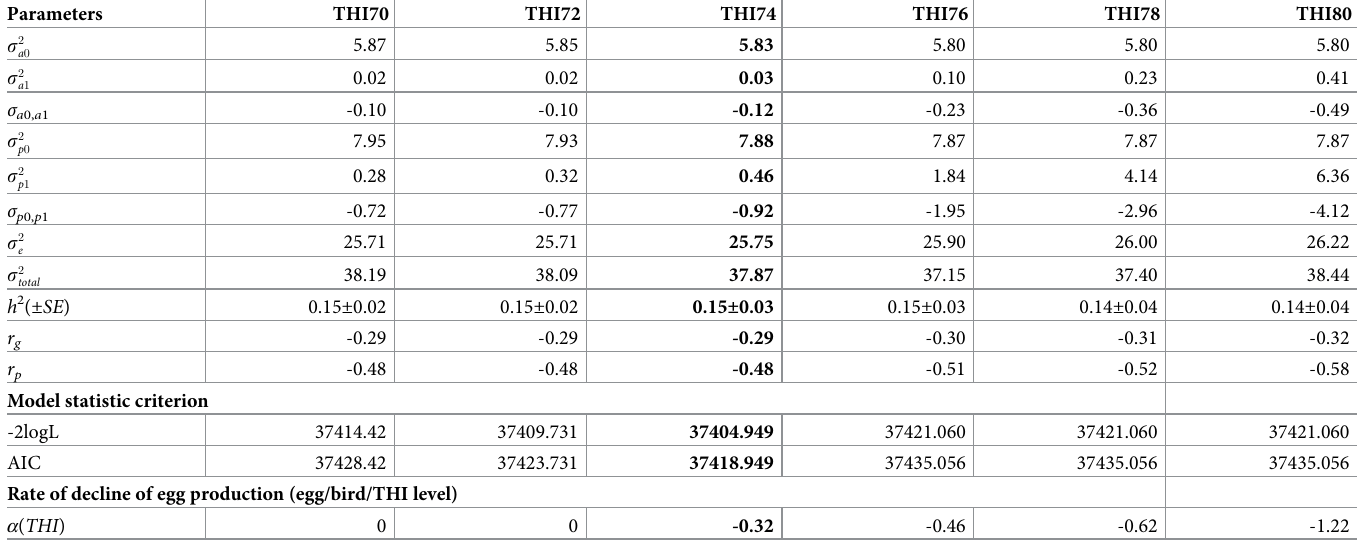
Table 3. Estimated variance components and genetic parameters for monthly egg production according to THI levels. Parameters